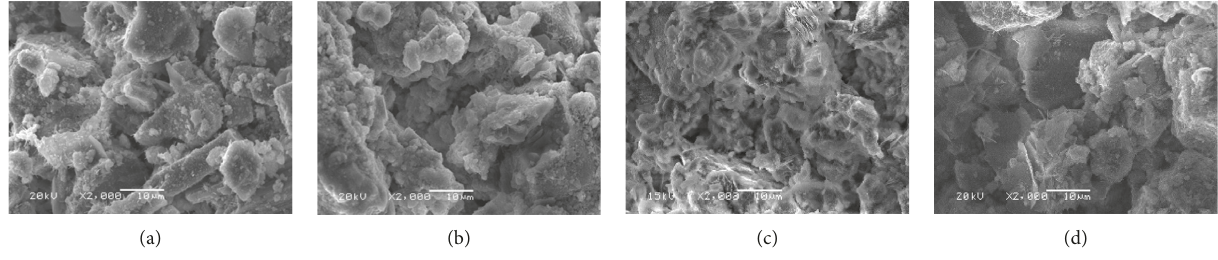
Figure 4: Microscopic scale SEM image sample set of the CPB.